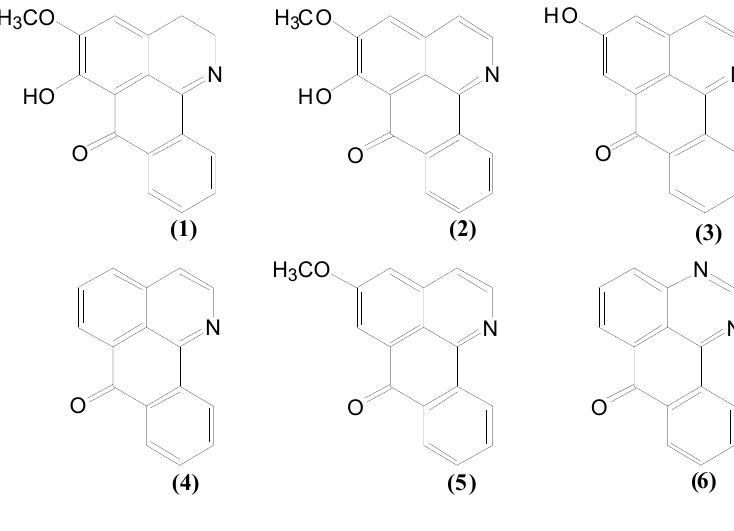
Figure 4. Chemical structures of oxoisoaporphine derivatives 1 – 6